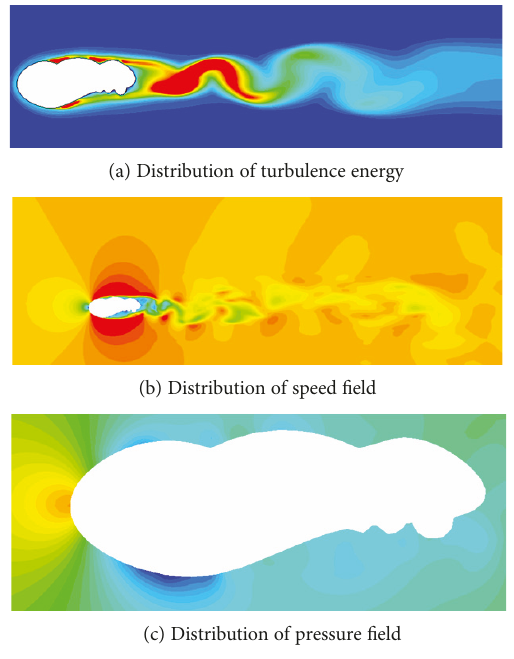
Figure 9: Flow fi eld distribution of optimized asymmetric cross- section